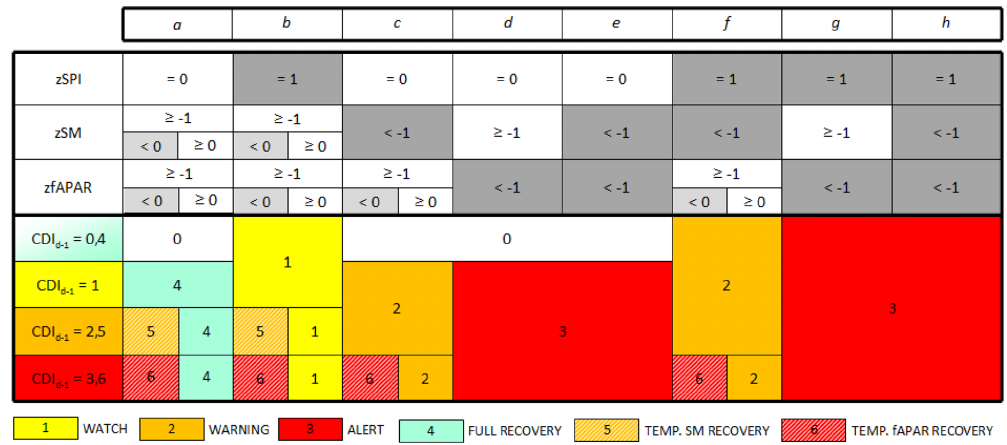
Figure 4. Schematic representation of the CDI-v2 computation procedure. The upper part of the table reports the eight possible combinations of the three main Boolean quantities (from a to h ), with sub-cases (based on the second set of thresholds) reported where used. The lower part of the table reports the corresponding CDI classes for all the antecedent CDI values (subscript d −